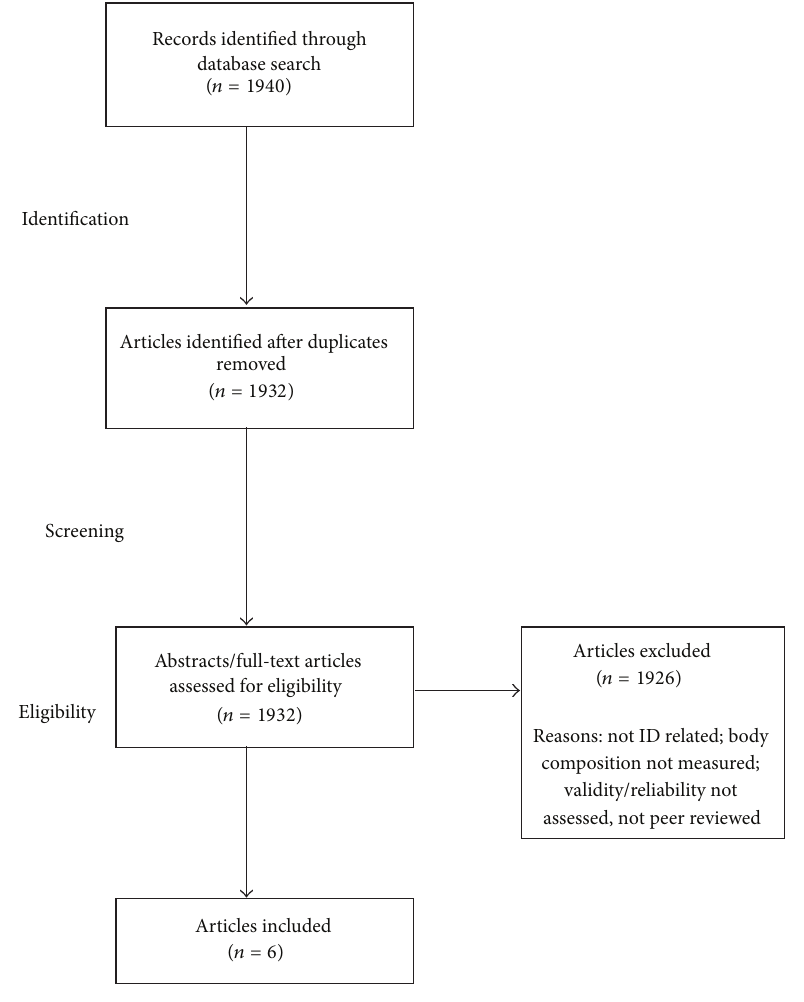
Figure 1: Scoping review of the literature on body composition measures for individuals with intellectual